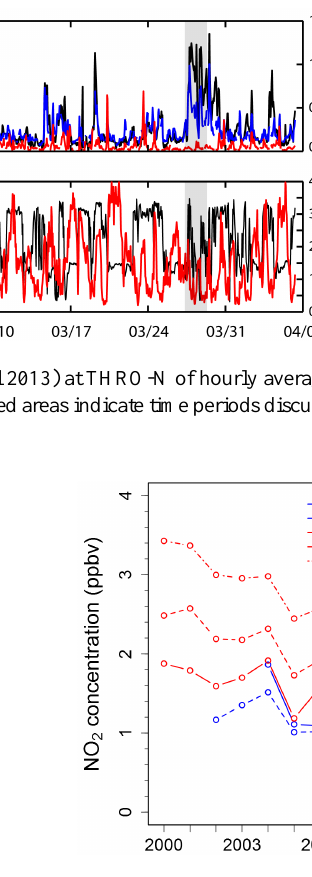
Figure 8. NO 2 monitoring data from the EPA AirData website. Data are annually averaged. Missing data points are for years which had less than 50% of the possible